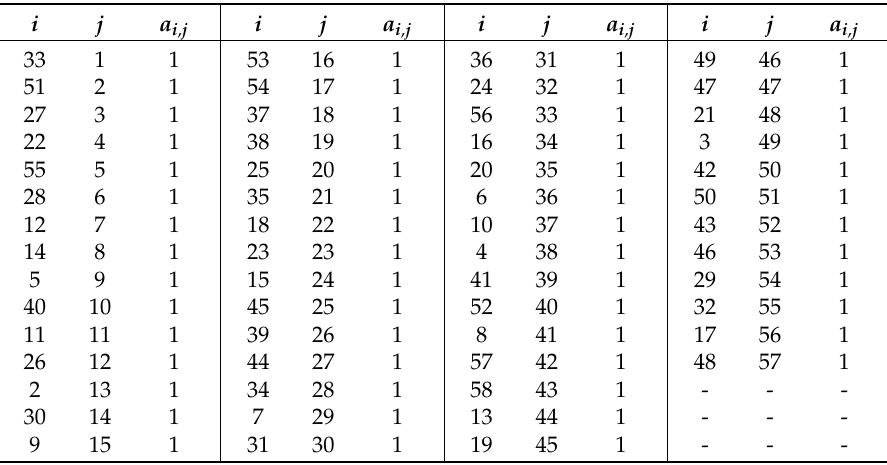
Table A5. The sparse expression of A c − p with degree-betweenness interface strategy.